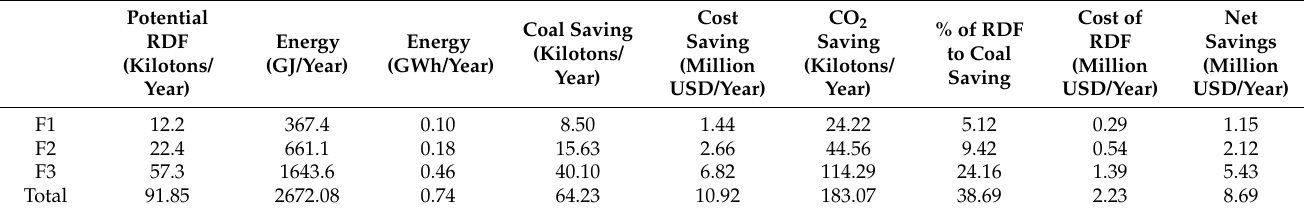
Table 6. Potential RDF